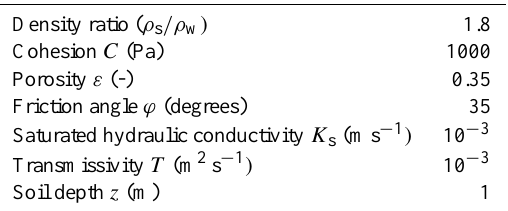
Table 1. Hydraulic and geotechnical parameters for the study